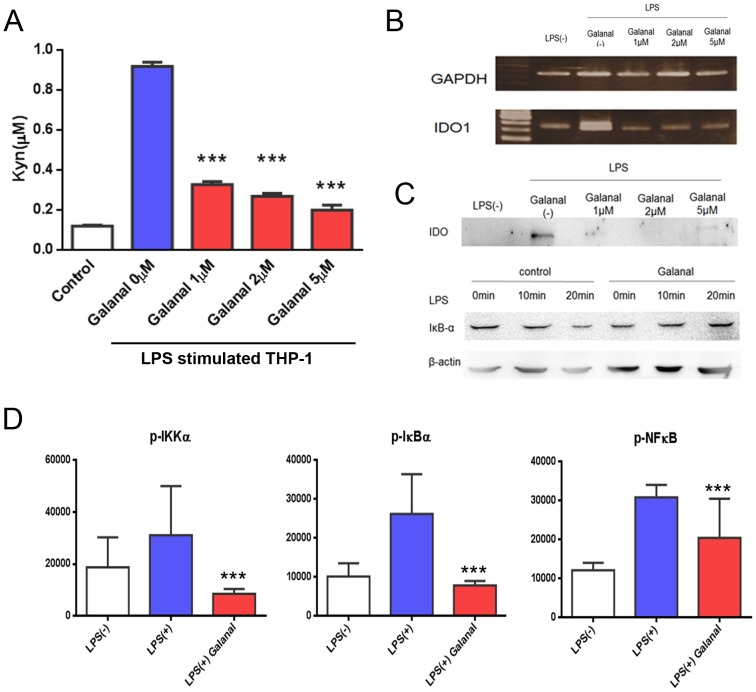
Inhibition by galanal of the NFκ-B signal transduction pathway.(A) L-Kyn formation in LPS (50 ng/ml)-treated THP-1 cells with and without various concentrations (1-5 µM) of galanal. L-Kyn formed after 24-hr incubation was measured by HPLC. Data are the mean ± SD. ***P<0.001. (B) Expression of IDO1 mRNA in LPS-treated THP-1 cells with and without galanal after 24 hrs incubation. The mRNA expressed was measured using RT-PCR. (C) Cytoplasmic expression of IDO1 and Iκ-Bα proteins in LPS (50 ng/ml)-treated THP-1 cells with and without galanal after 24 hrs incubation. (D) The phosphorylation of IKK-α, IκB-α, and NFκ-B in LPS (50 ng/ml)-treated THP-1 cells with and without galanal after 60-min incubation. Data are the mean ± SD. ***P<0.001.